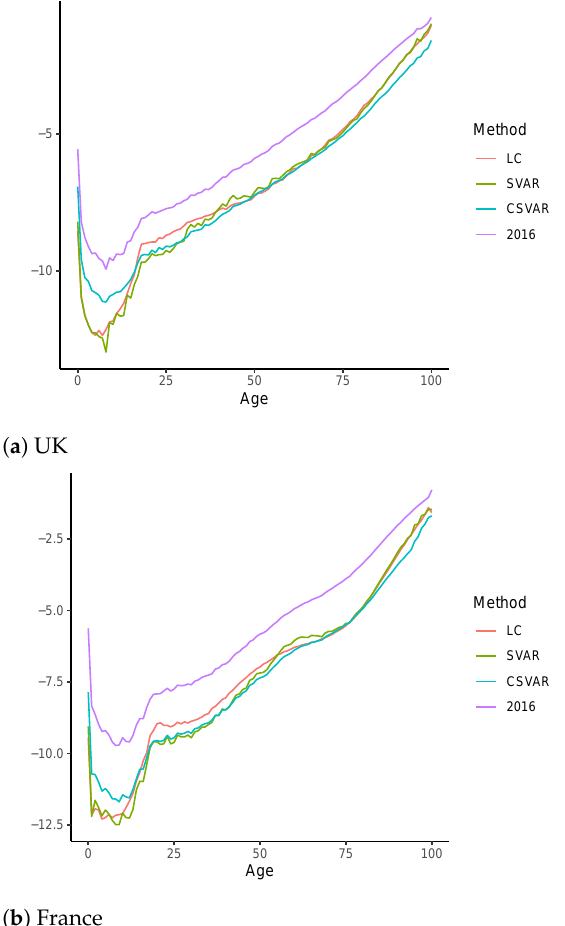
Figure 3. Projected and actual log central death rates: 2016 vs.